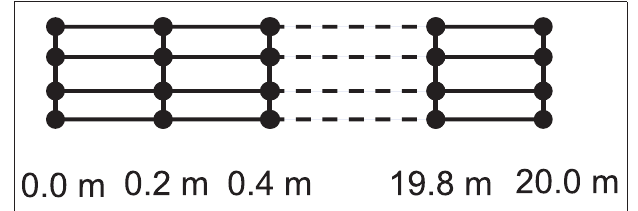
FIGURE 3 | Numerical grid for green roofs realized in